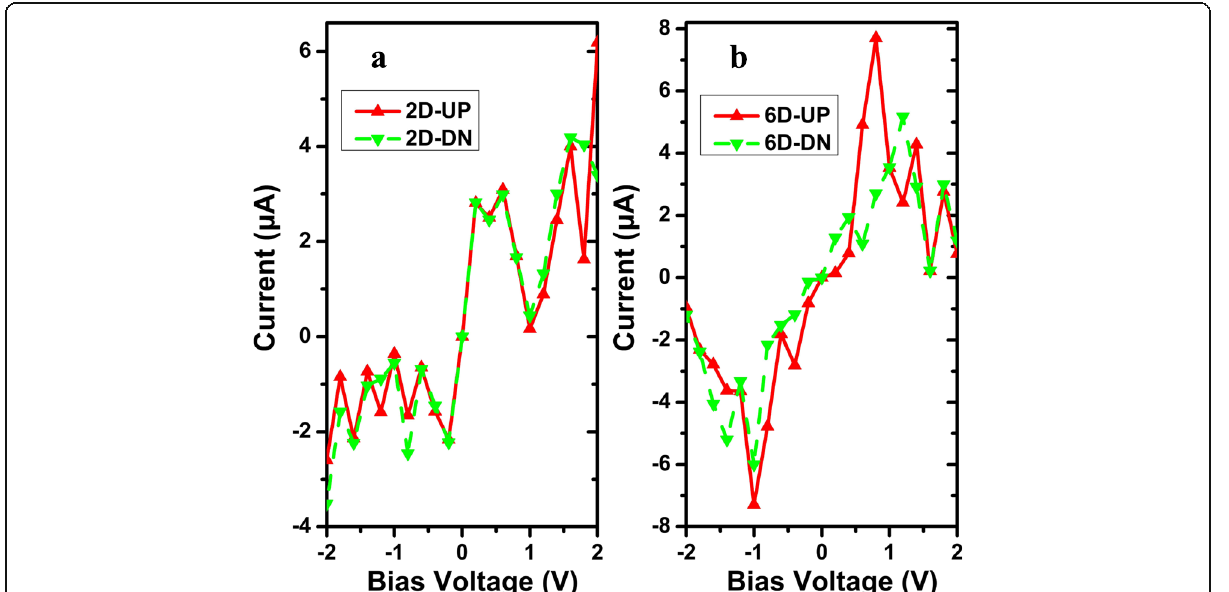
Fig. 6 (Color online) The spin-dependent I-V curves of A γ GYNRs with a single N-doping and b double N-doping, whose models are shown as M 2D and M 6D in Fig. 1. All the models only consider the structures considering the molecular chain with four repeated molecular units as